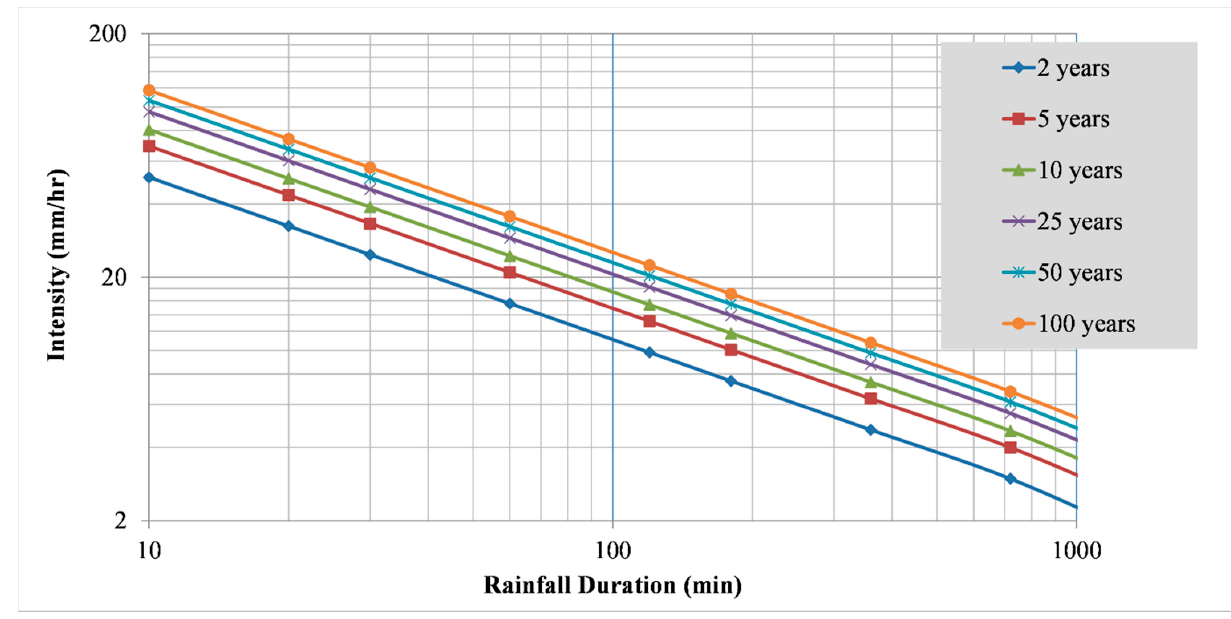
Figure 3. IDF curves generated using the Gumbel method on log-log scale.